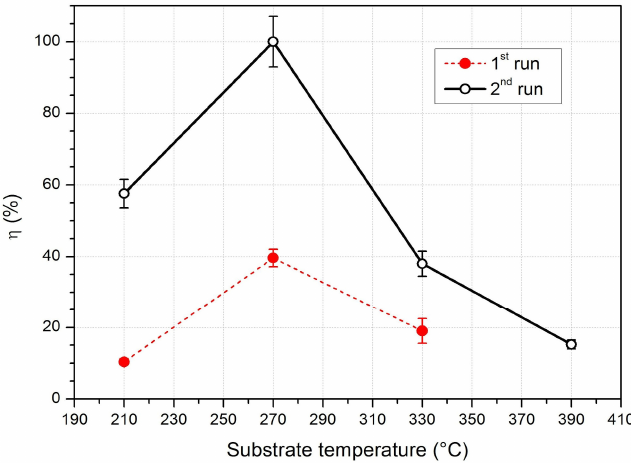
Figure 8. Efficiencies of SnS solar cells made with different substrate temperature; first and second runs after refilling of the source.